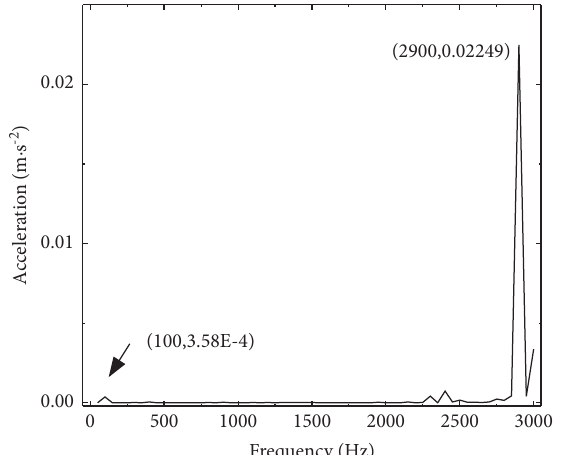
Figure 13: Radial vibration response of the busbar shell in ANSYS Workbench.